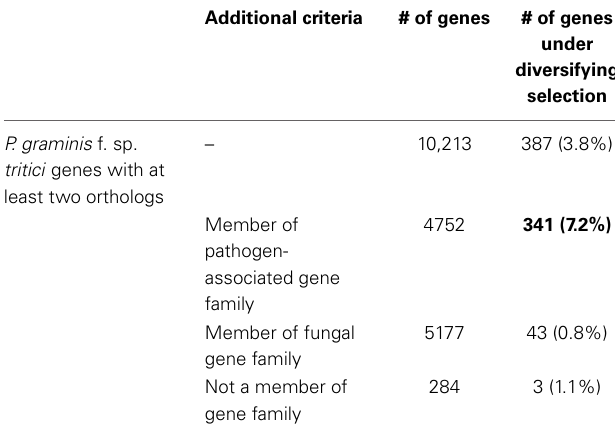
Table 3 | Diversifying selection in the wheat stem rust is predominantly detected across pathogen-associated gene